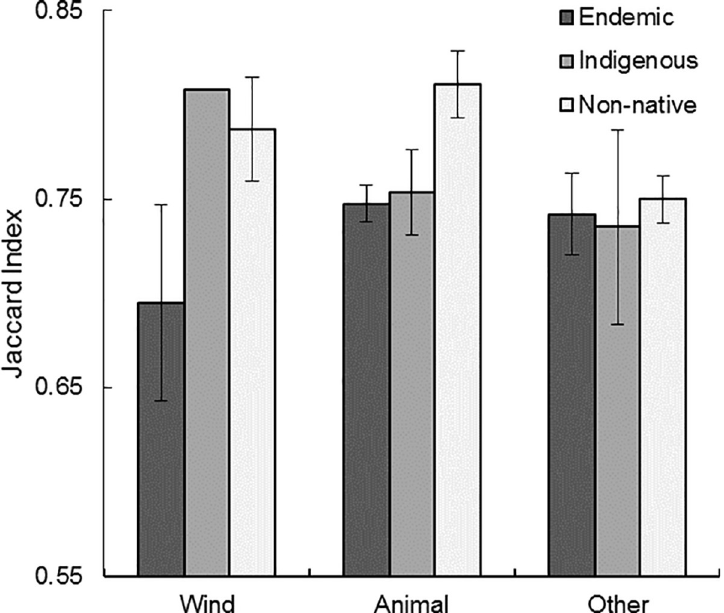
Fig 8. Species specialization by dispersal syndrome. As hypothesized, no significant difference was detected among dispersal syndromes across the specialization continuum ( p = 0.071) when controlling for differences among biogeographic origin (Table 5). Mean values and standard errors are